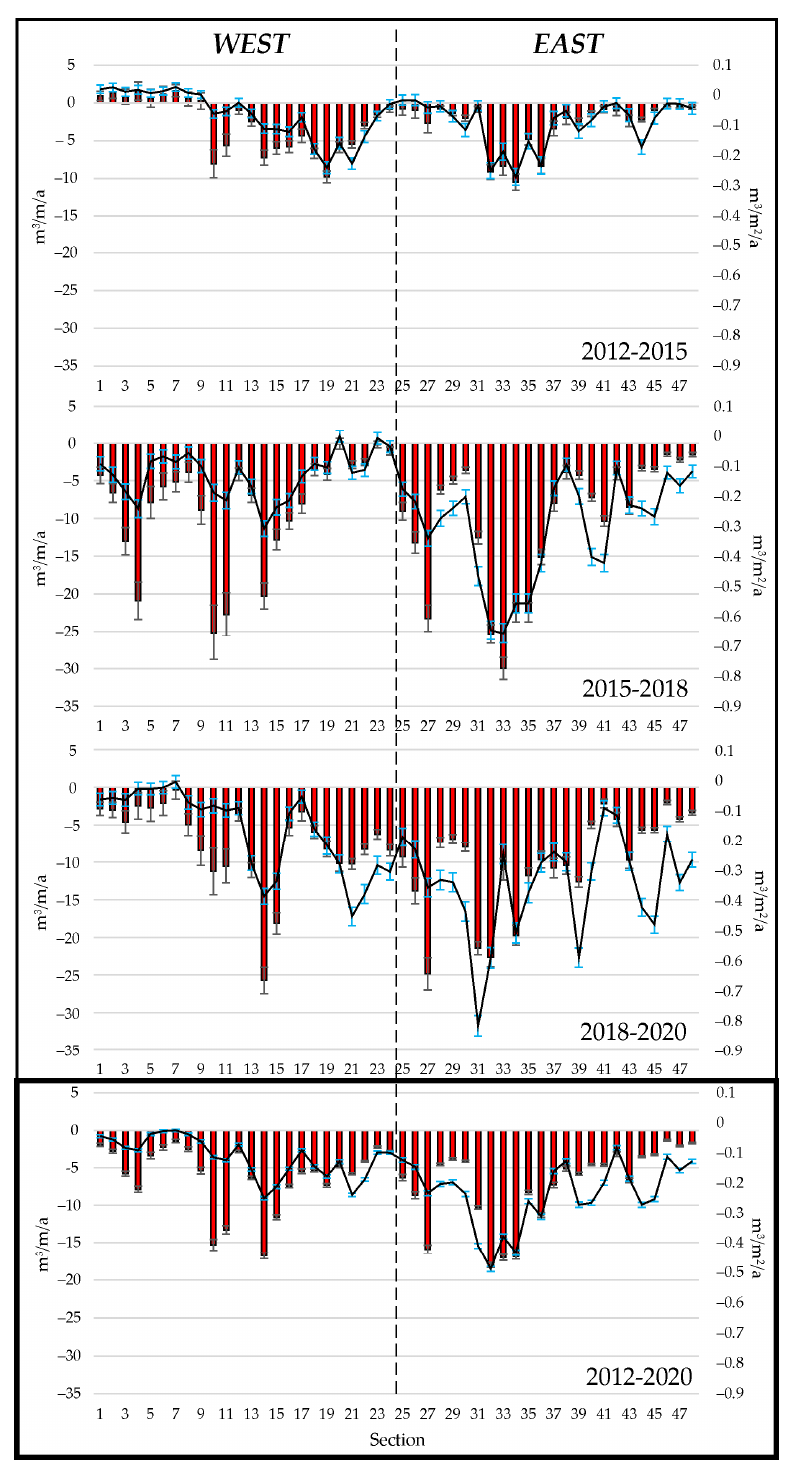
Figure 7. Spatial differentiation of the budget of sediments in individual sectors in the analyzed time periods. Raw data source—Maritime Office in Szczecin.